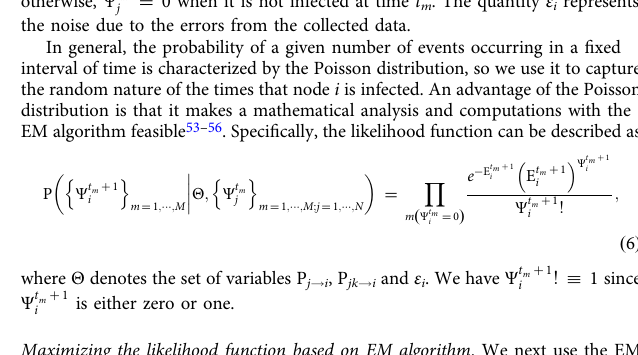
Fig. 4 Schematic illustration of reconstructing a 2-simplicial complex based on binary social contagion. a A 2-simplicial complex of size N = 30, where the black links represent 1-simplexes and the orange shadows represent 2-simplexes. b Data matrix S that stores all nodes ’ states at different time steps, where each row is a time string representing all nodes ’ states at that time step and each column is a node ’ s state at different time steps, where the black and blank squares denote the 1 and 0 states, respectively. Take node 13 as an example (the red frame), the values of P 13 j 8 j ≠ 13 ð Þ and P 13 jk 8 j ≠ k ≠ 13 ð Þ can be ¼ 1 = 2 (the green frame) and P 13 ¼ 1 (the purple frame). c The values of P j → calculated from data matrix S : P 13 13 and P jk → 13 are obtained through the EM 7 28 ; 30 algorithm, where only non-zero values of P j → 13 and the top 10 values of P jk → 13 are shown. d The values of P j → i (each column in the left subgraph) and P jk → i (each column in the right subgraph) for each node i based on the method described in Secs. 4.1.1 and 4.1.2, where the blue and red dots denote the actual and nonexistent two-body or three-body connections, respectively. e The 2-simplicial complex is inferred based on the probabilities in ( d ), in which the two-body connections are exactly predicted, but two 2-simplexes (5, 20, 22) and (13, 18, 29) in ( a ) cannot be predicted (marked by the light-yellow shadows). f The values of P 0 j ! for node 13 obtained by iterating Eqs. 22 – 25, and only non-zero values are shown. g Compressed data matrix that records 13 only the columns in S giving P 0 j ! 0. h The values of P j → 13 and P jk → 13 for node 13 based on the compressed data in ( g ). i The values of P j → i and P jk → i 13 >